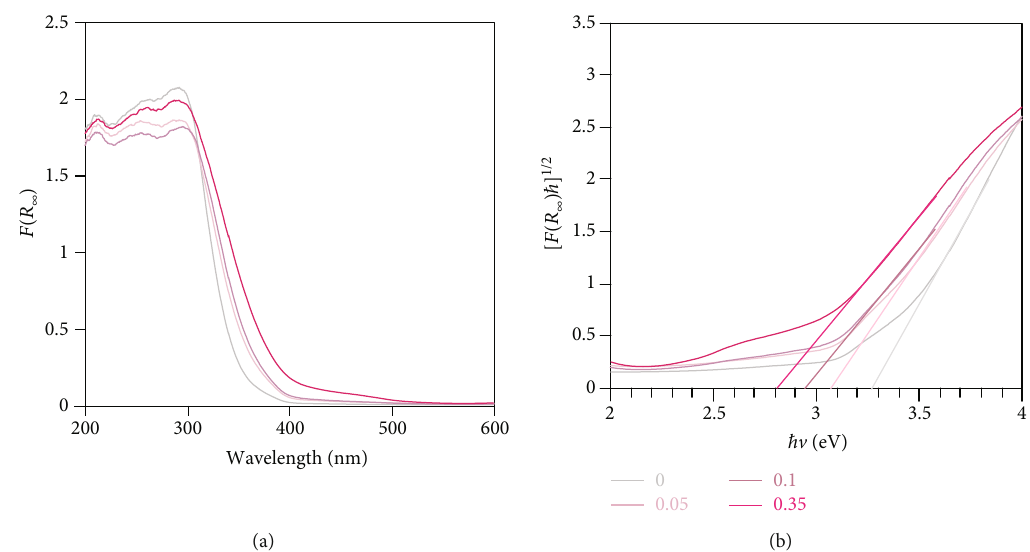
Figure 7: (a) UV-vis DR spectra and (b) Tauc plots of HTNO ( x )_600, x = 0 , 0.05, 0.1, and 0.35.